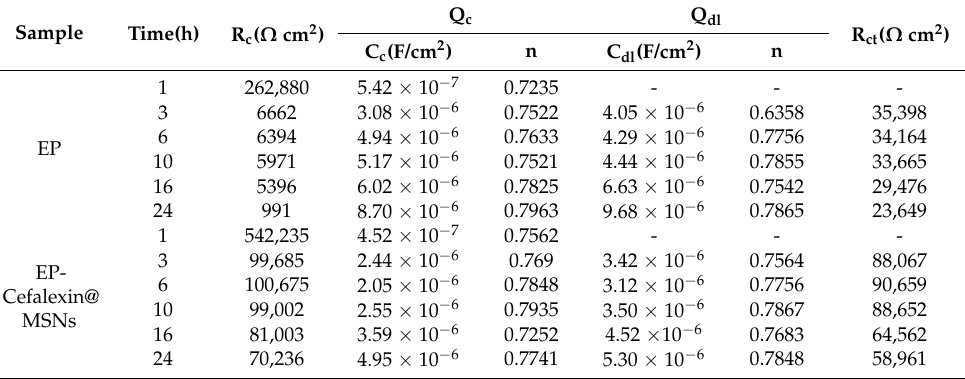
Table 3. The EIS fitting parameters for the different coatings after immersed in 3.5 wt% NaCl solution for different